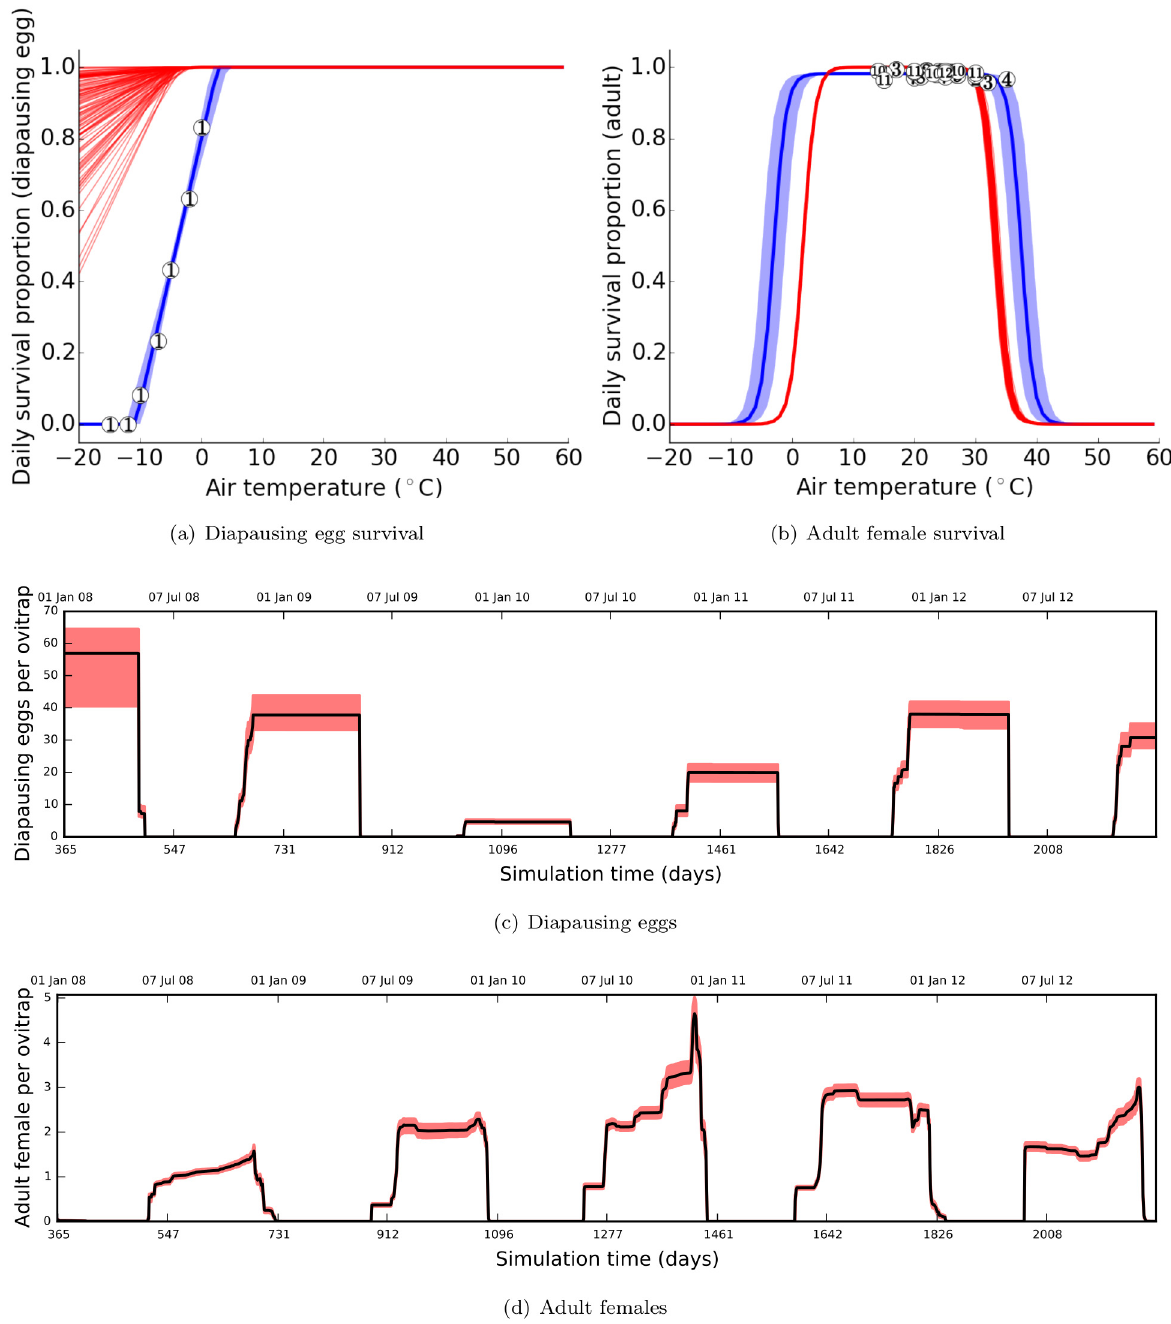
Fig 5. Cold resistance for adults and diapausing eggs with Θ 1. Prior (blue) and posterior (red) distributions of diapausing eggs (a) and adult females (b) are shown with data from literature (numbered circles). The prior distribution is represented by a solid line (mean) and a shaded region (95% confidence interval). The posterior distribution is represented by 100 samples drawn from the posterior mode Θ 1. Daily average diapausing eggs (c) and adult females (d) per ovitrap are simulated with Θ 1. The solid line represents the mean and the red shade represents the 95% confidence interval. (a) 1: [52], (b) 1: [71],